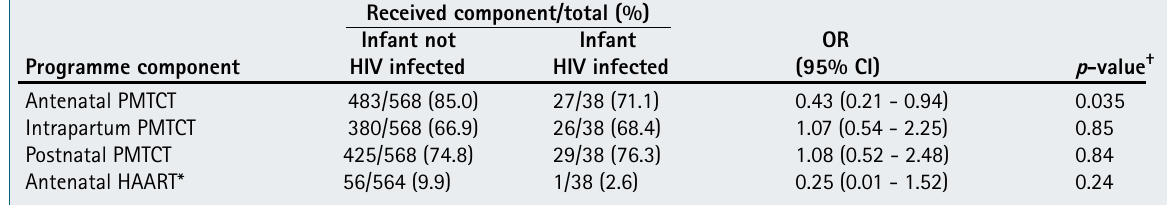
TABLE II. UNIVARIATE ANALYSES